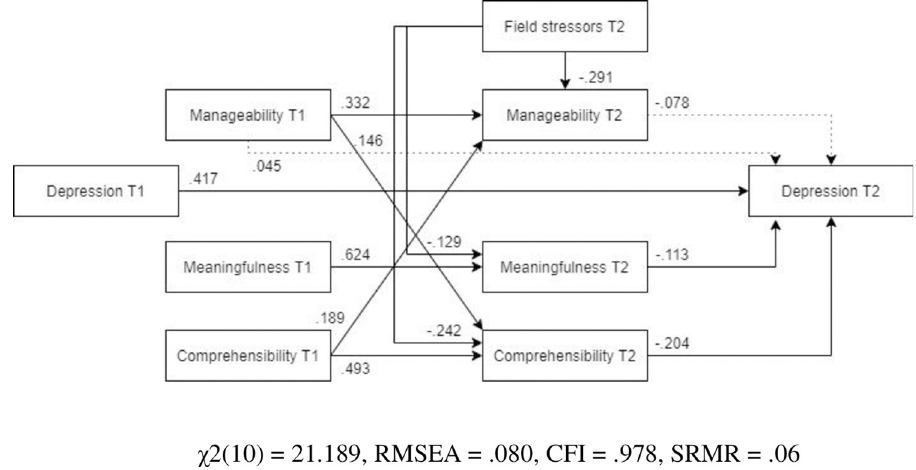
Fig 8. Tested structural equation model for depression—males. χ 2(10) = 21.189, RMSEA = .080, CFI = .978, SRMR = .06.